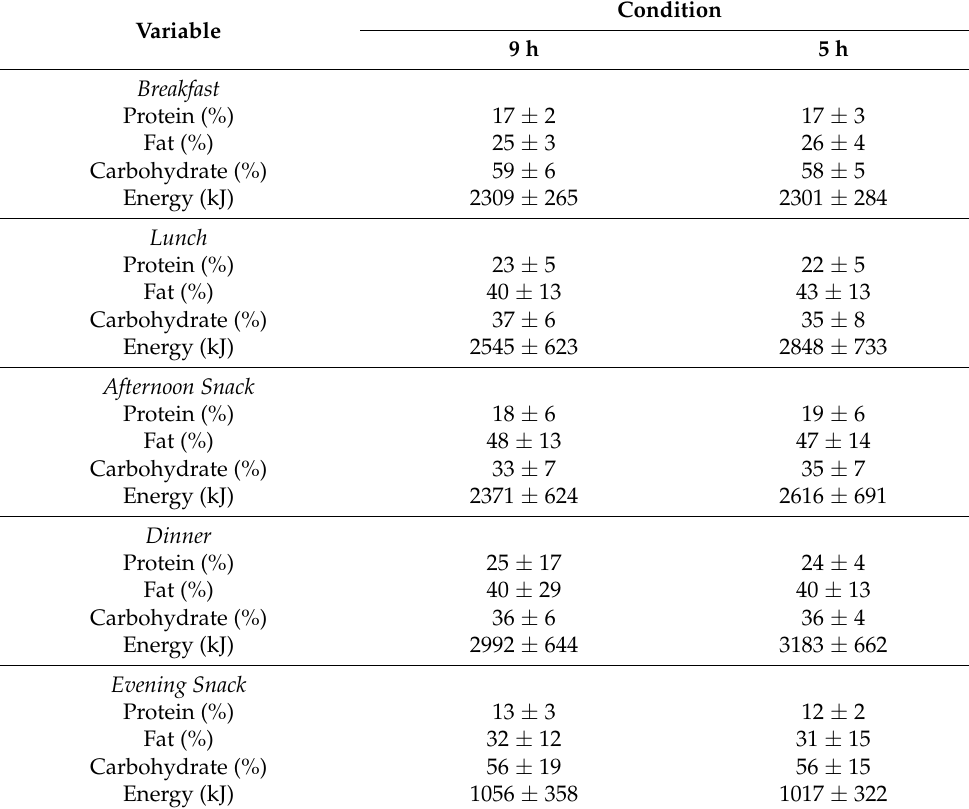
Table 1. Components of meals and snacks consumed during the study